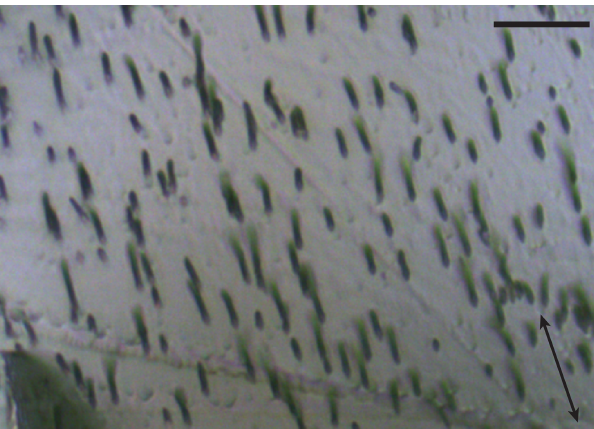
Figure 2. Implanted and well-etched 252 Cf fission tracks in Har- court granodiorite monazite. Tracks are implanted on surfaces par- allel to the (100) pinacoid. The arrow indicates the direction of the c axis. The enlarged image was taken with a 100 × dry objective; the scale bar is 10µm.